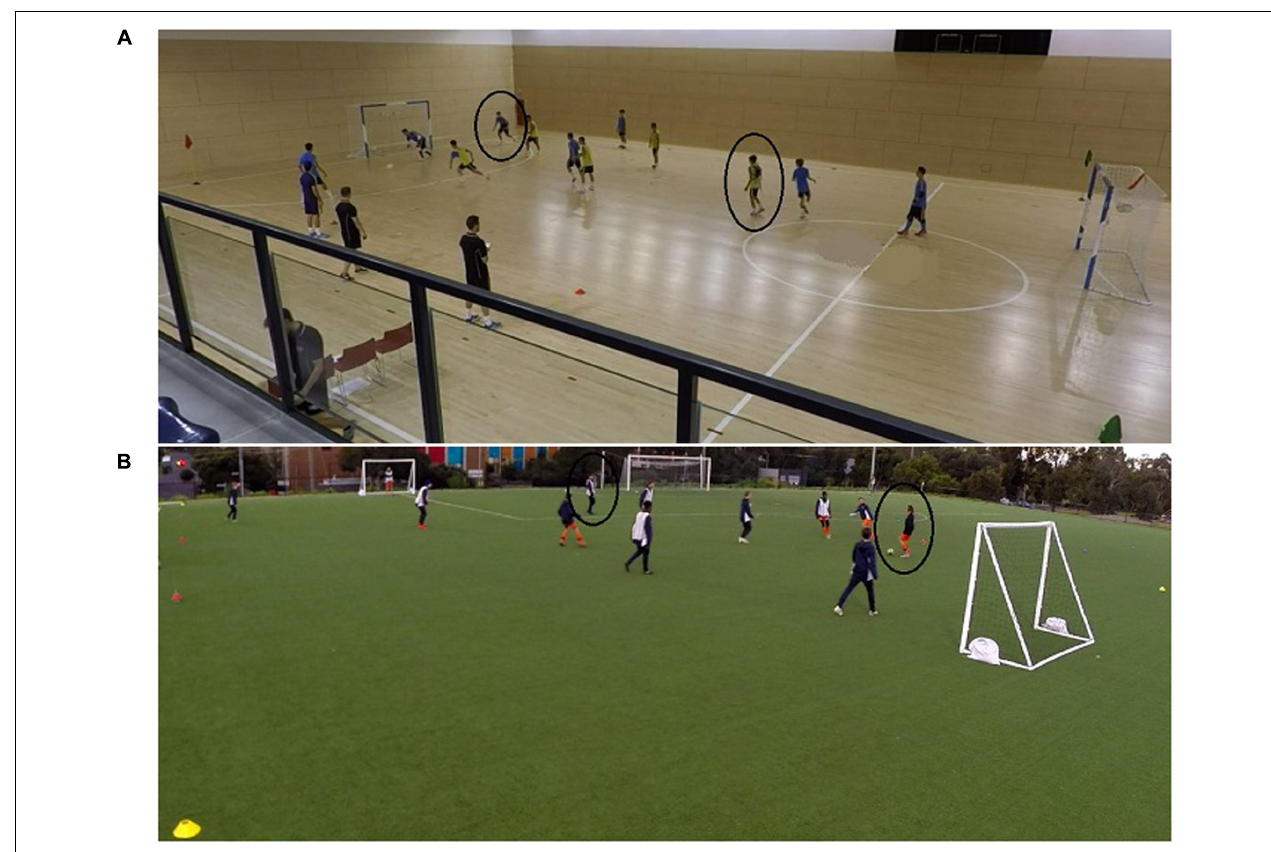
FIGURE 1 | Example of futsal task (FUT) task (A) and soccer task (SOC) task (B) . The two participants wearing the scene camera are highlighted in the circles. The goals were futsal-size goals to discourage shooting and encourage passing in the SOC